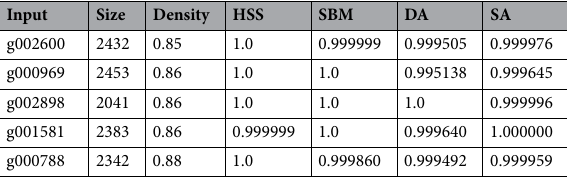
Table 3. Results for small and dense classes, same as Table 1.